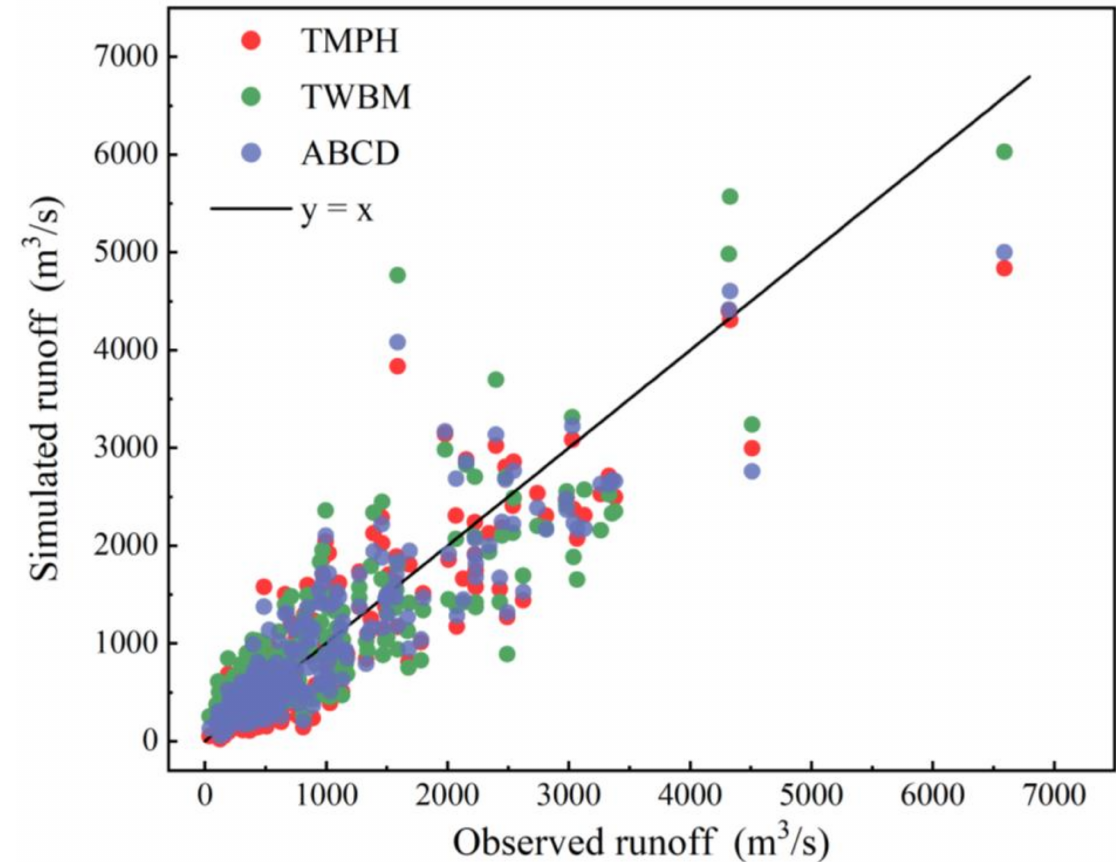
Figure 4. Scatter plots of observed and simulated monthly runoff by TMPH, TWBM, and ABCD in calibration